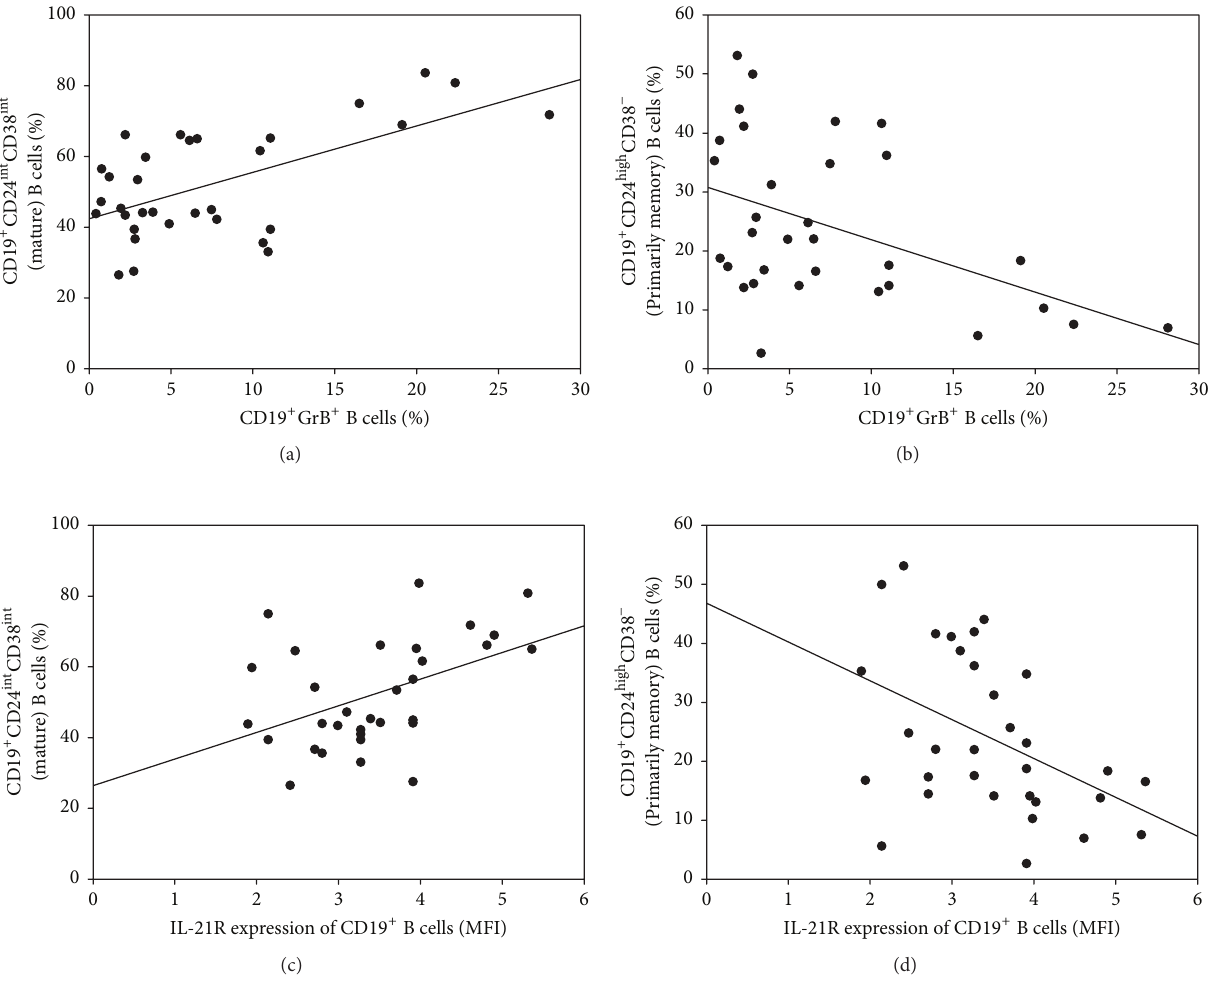
Figure5:CorrelationanalysisbetweengranzymeBandinterleukin-21 receptorexpressionandBcellsubsets.Associationsbetweengranzyme B expression of CD19 + B cells and (a) percentages of CD 19 + CD 24 int CD 38 int mature B cells ( 𝑅 = 0.4022 , 𝑝 = 0.0224 ) as well as (b)